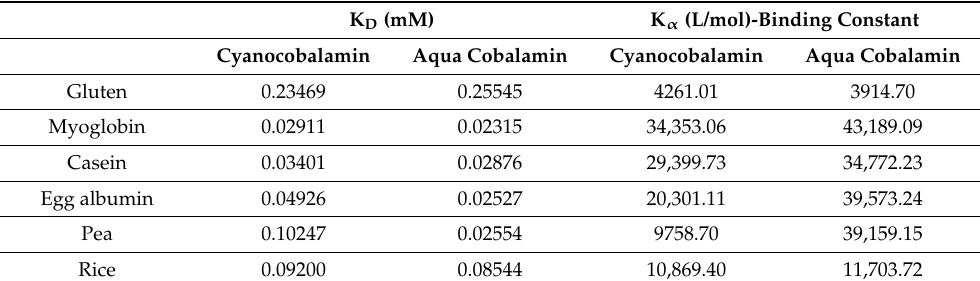
Table 2. K D and K α of vitamin B12 and protein